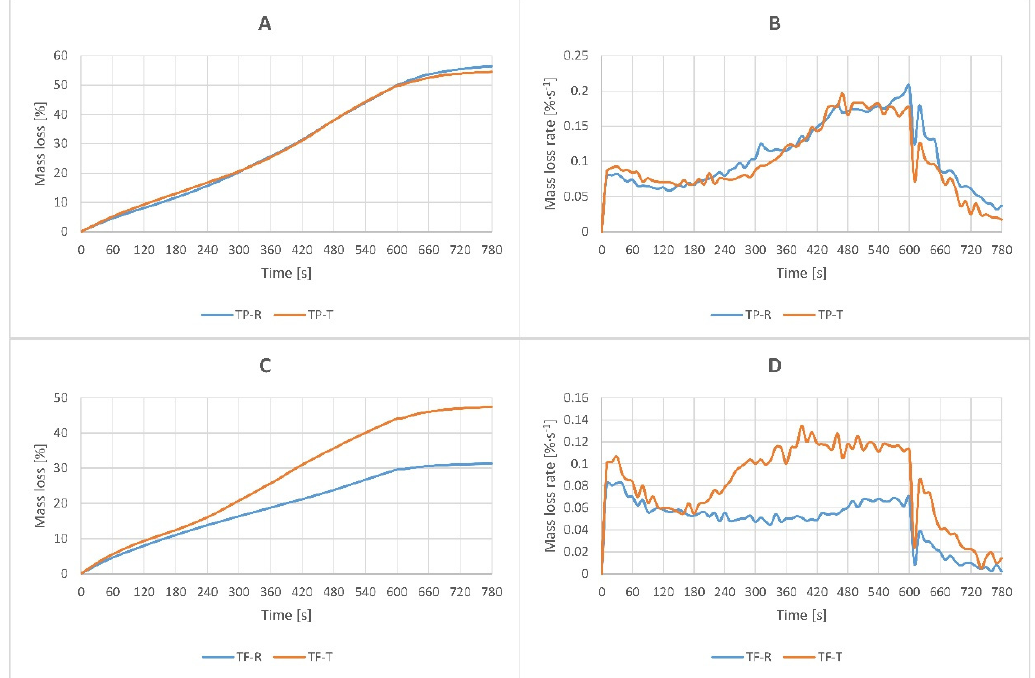
Figure 5. Mass loss and mass loss rate over time of thermowood specimens. ( A ) Mass loss of specimens TP − R and TP − T; ( B ) Mass loss rate of specimens TP − R and TP − T; ( C ) Mass loss of specimens TF − R and TF − T; ( D ) Mass loss rate of specimens TF − R and TF − T.